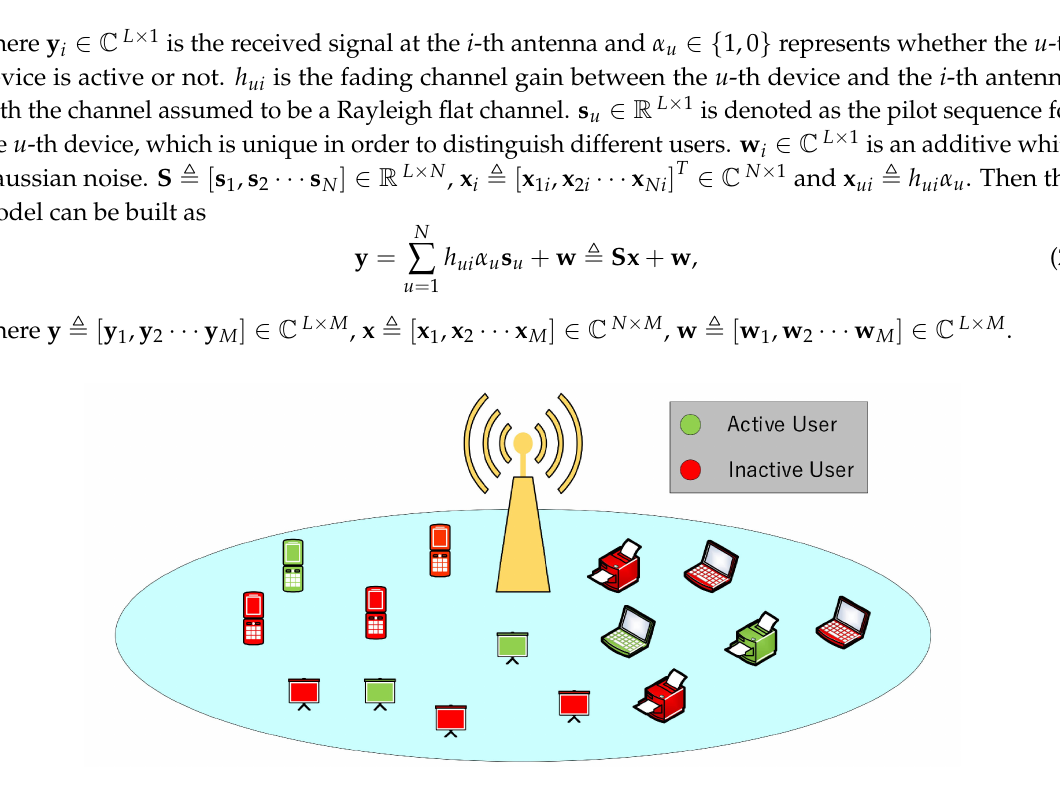
Figure 1. Uplink grant-free transmission system with a base station (BS) and massive